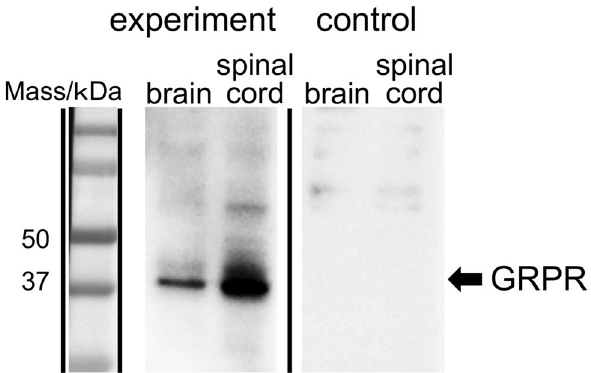
Figure 6. Western immunoblotting of gastrin-releasing peptide receptor (GRPR). The number on the left indicates the molecular weight (kDa). Extracts of protein from Xenopus brain and spinal cord were transferred onto polyvinylidene difluoride membranes and probed with the rabbit polyclonal antiserum against Xenopus GRPR (1:100,000). The antiserum recognized a single band at the expected molecular weight of GRPR (~ 43 kDa) on a Western blot of the brain and spinal cord. Preabsorption of the antiserum with an excess of antigen peptides (50 μg/ml) eliminated the staining of the ~ 43-kDa protein band. The gel image was processed by cropping to remove the irrelevant area. Original images are shown in Supplementary Fig.